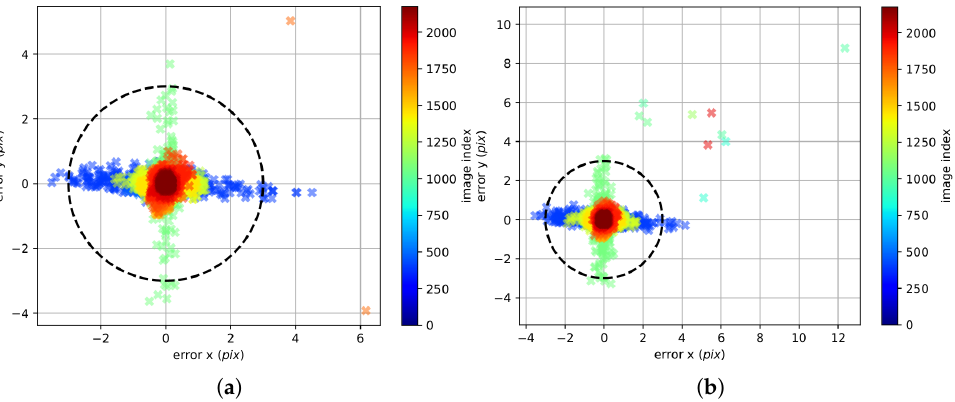
Figure 8. ( a ) Left cam reprojection error; ( b ) Right cam reprojection error. ROS kalibr reprojection errors after the calibration optimization process. Mean reprojection error (left cam) px: 0.1627. Mean reprojection error (right cam) px: